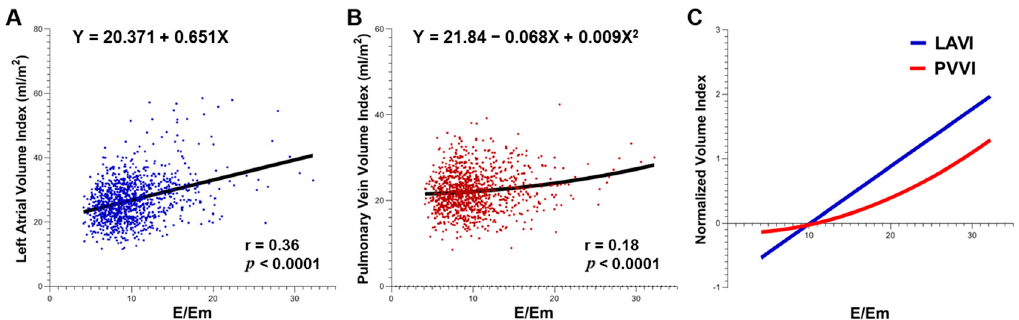
Figure 4. A and B: Correlations of E/Em with LAVI and PVVI, respectively. C: Curve comparison based on normalized LAVI and PVVI values. The difference in E/Em-related changing patterns between LAVI and PVVI is well shown. E/Em = the ratio of the early mitral flow velocity (E) to the early mitral annular tissue velocity (Em), LAVI = left atrial volume index, PVVI = pulmonary vein volume index.